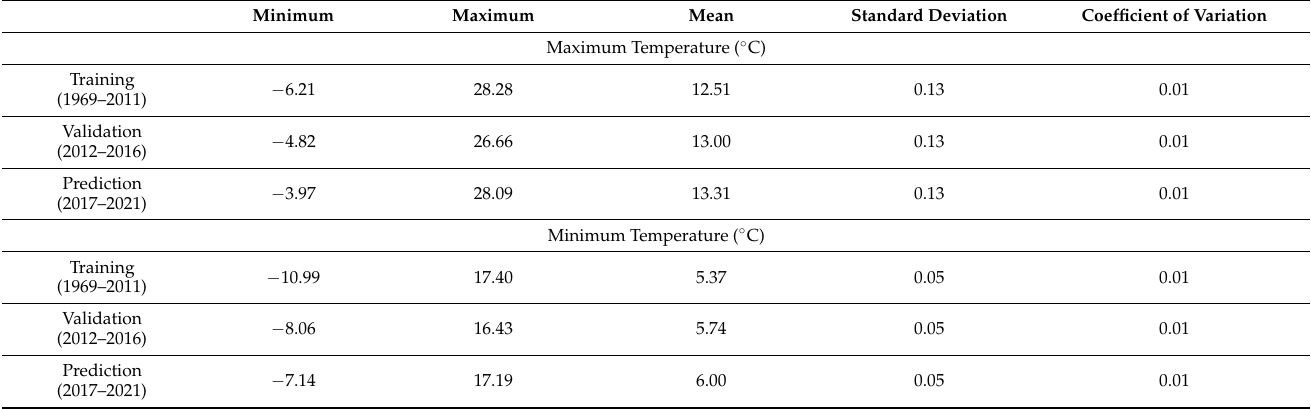
Table 1. Descriptive statistics of the input data used for ANN model development.